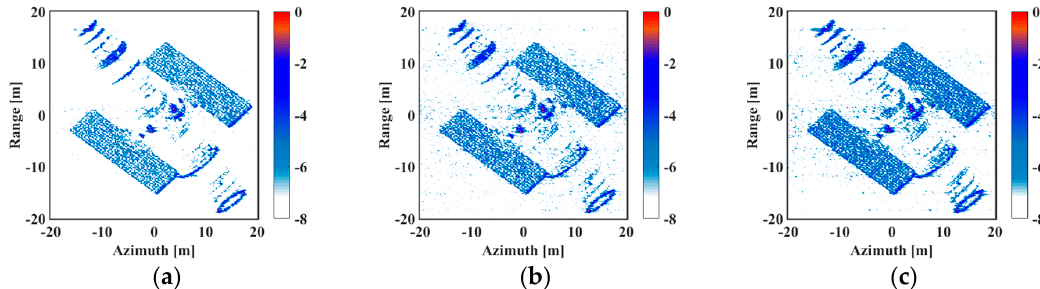
l -norm algorithm under different SNRs: ( a ) SNR = 10 dBs; 1